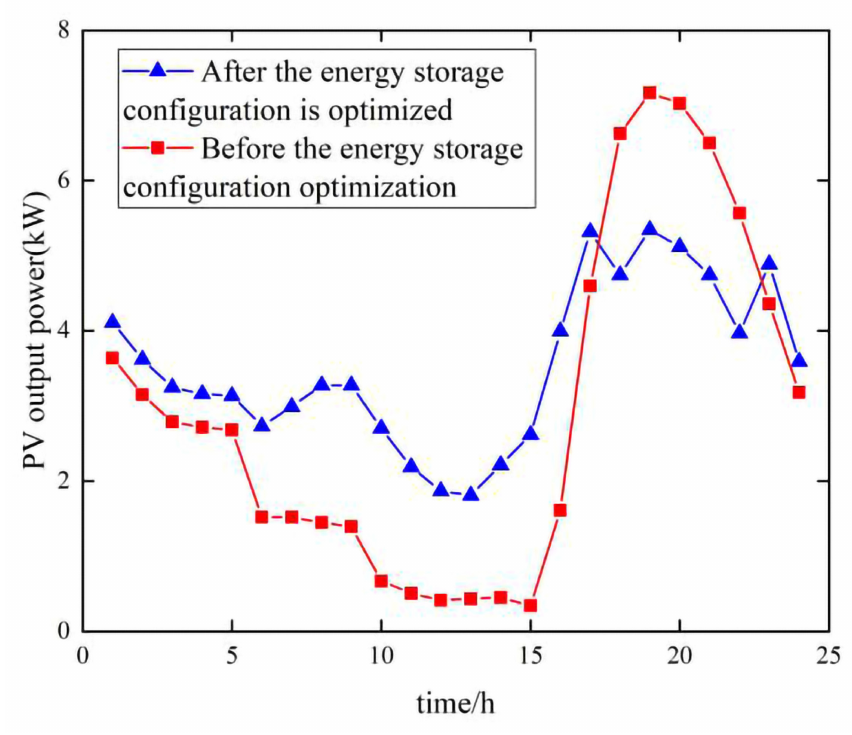
Figure 16. Distribution network load curve before and after energy storage configuration optimization under 45% photovoltaic penetration